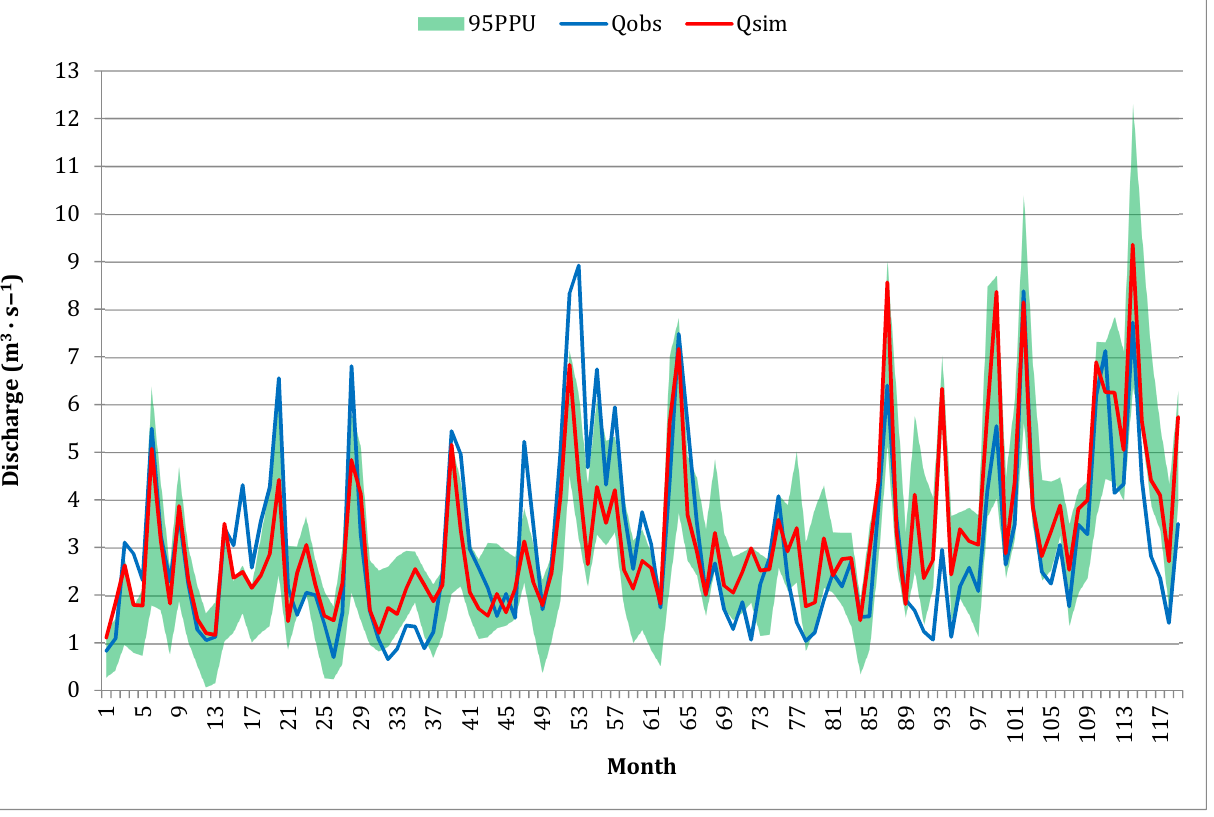
Figure 6. The 95PPU plot between observed and best simulated discharges after the calibration procedure.